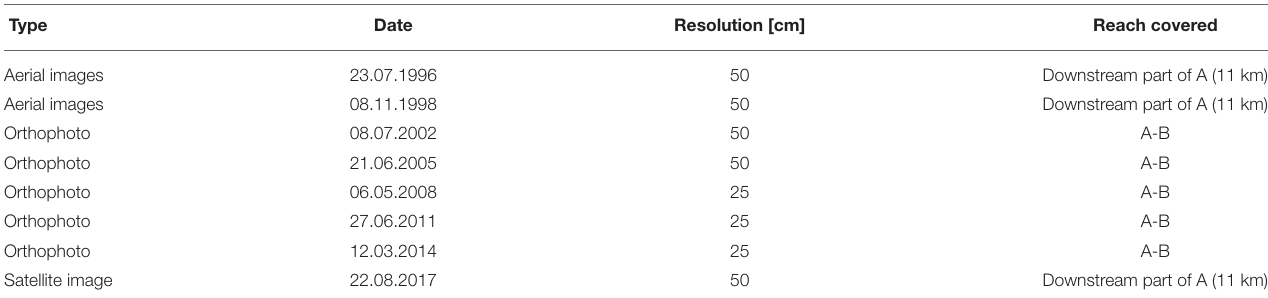
TABLE 1 | List and characteristics of the imagery used in the